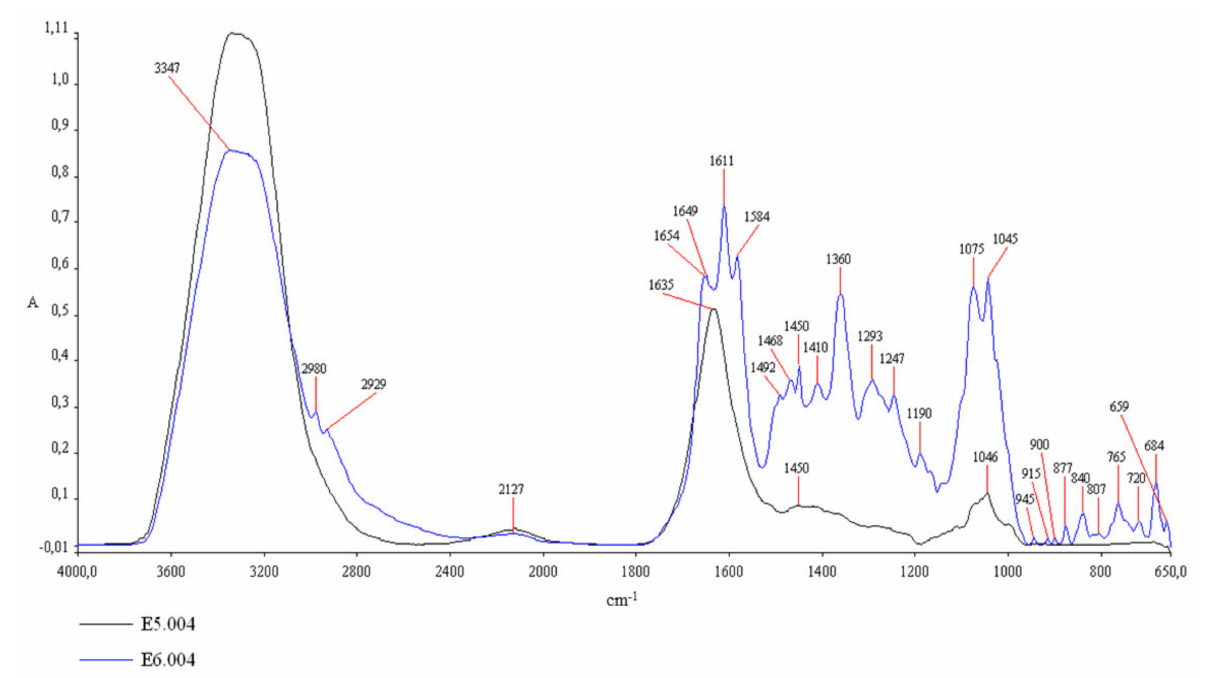
Figure 9. The FT-IR spectra of Glycyrrhiza L. extract (E5.004) and S. baicalensis extract (E6